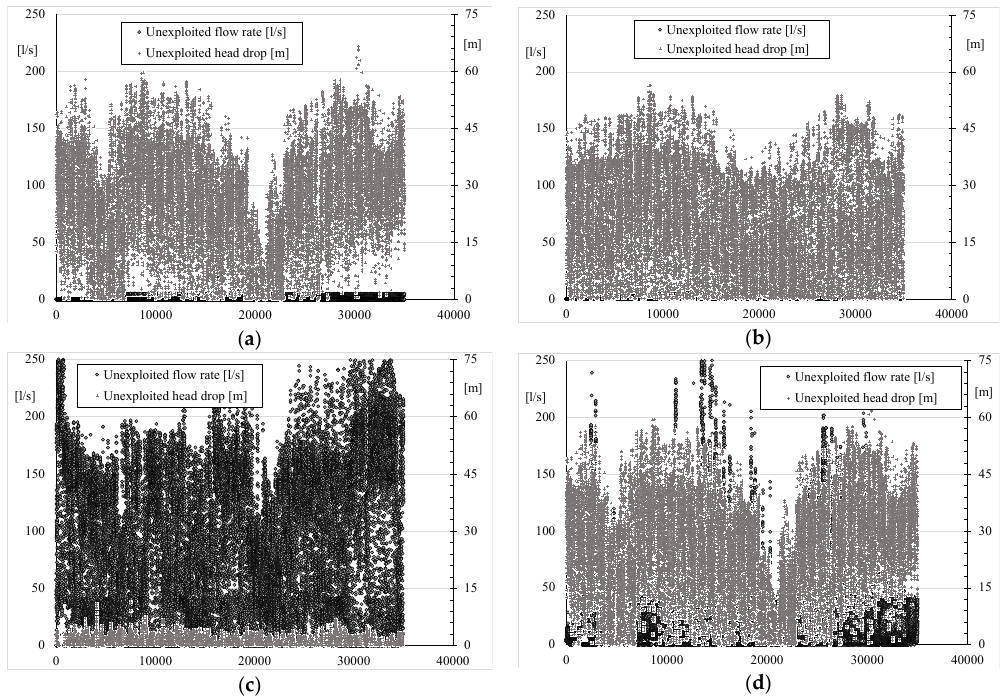
Figure 7. Unexploited flow rate and head drop for ( a ) WDN A and PAT #1; ( b ) WDN B and PAT #2; ( c ) WDN C and PAT #4 and ( d ) WDN D and PAT #4.